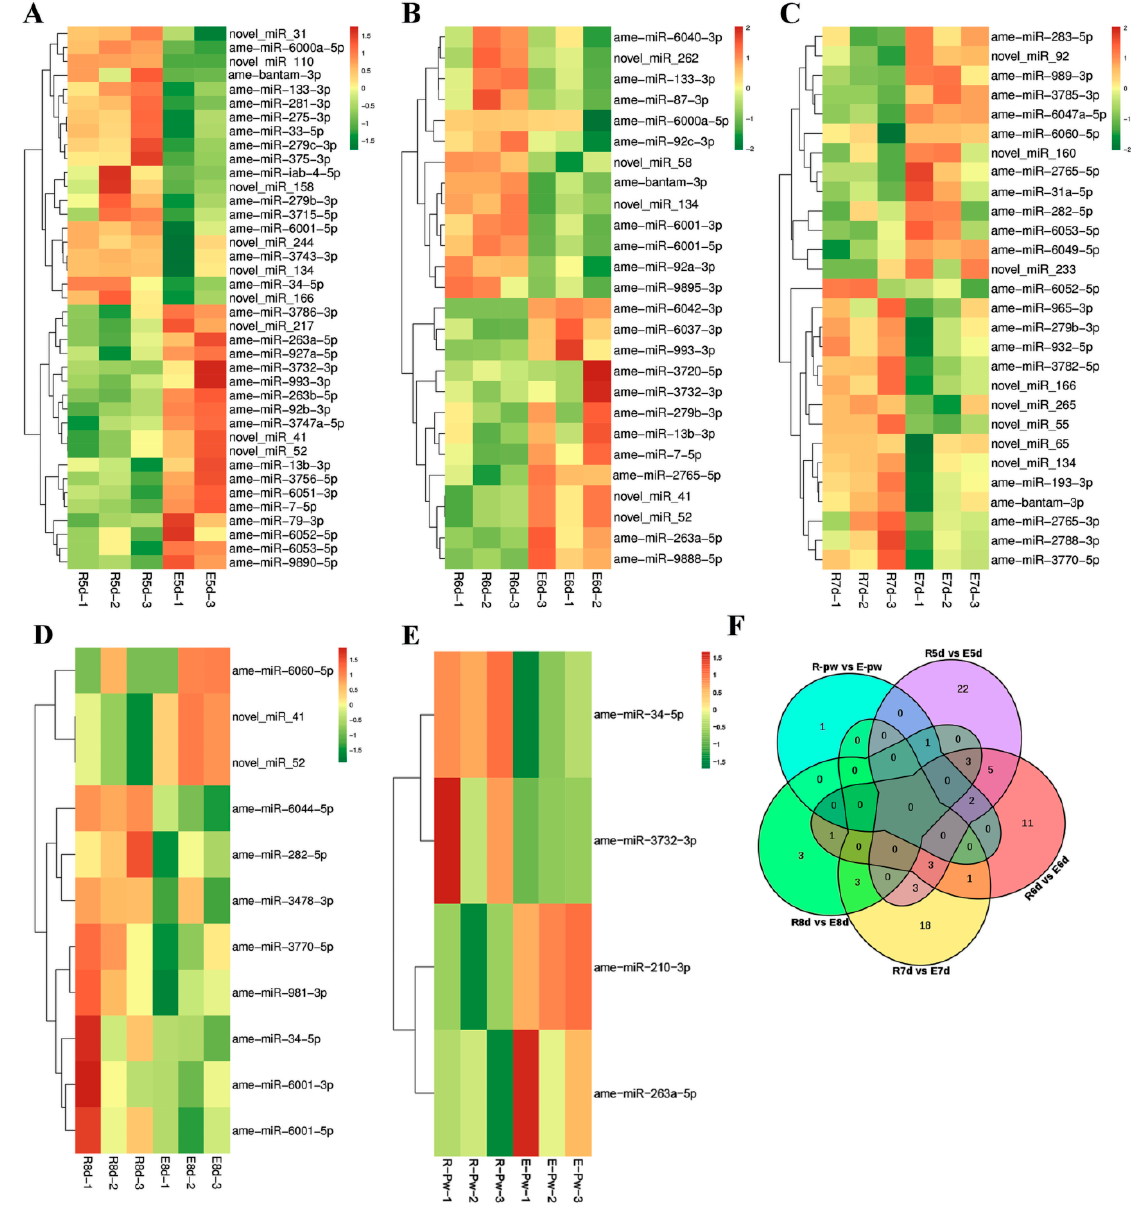
Figure 2. 20-Hydroxyecdysone (20E)-responsive miRNAs identified by small RNA sequencing. Hierarchical cluster analysis in ( A ) R5d vs. E5d; ( B ) R6d vs. E6d; ( C ) R7d vs. E7d; ( D ) R8d vs. E8d; and ( E ) R-Pw vs. E-Pw. The green and red rectangles indicate downregulated and upregulated miRNAs, respectively. Venn plot ( F ) of differentially expressed (DE) miRNAs among all examined samples. Numbers represent the identified DE miRNAs in pairwise comparisons.